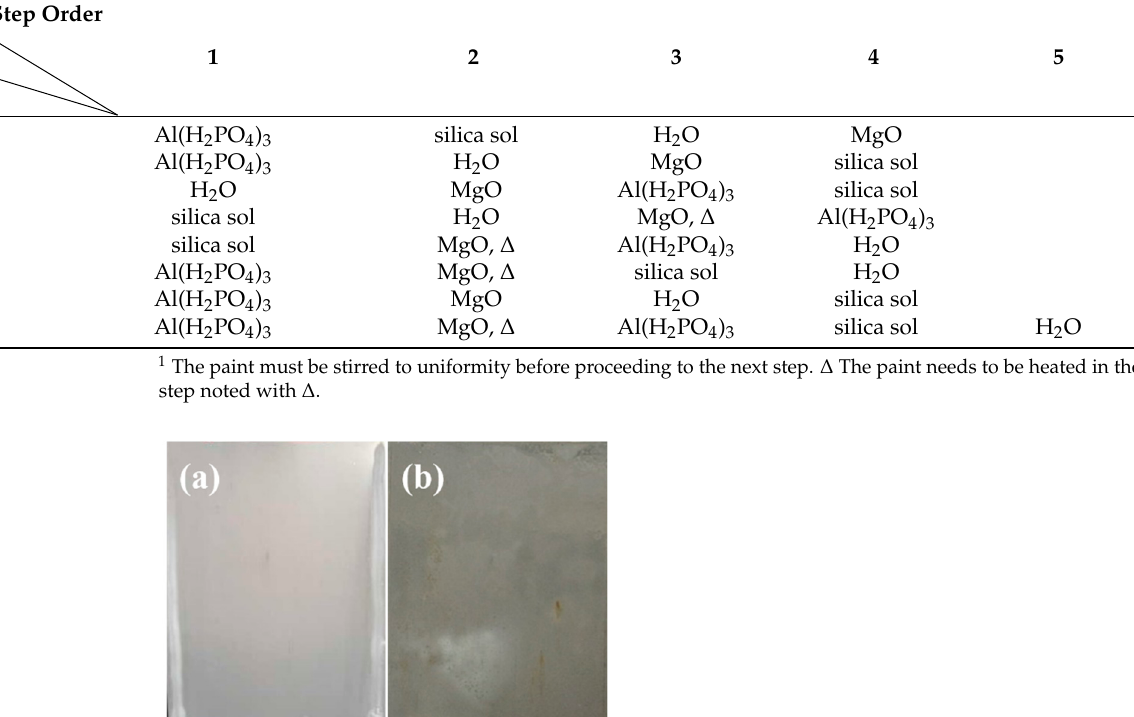
Table 7. The coating with different content of Li 2 SiO 3 or K 2 SiO 3.